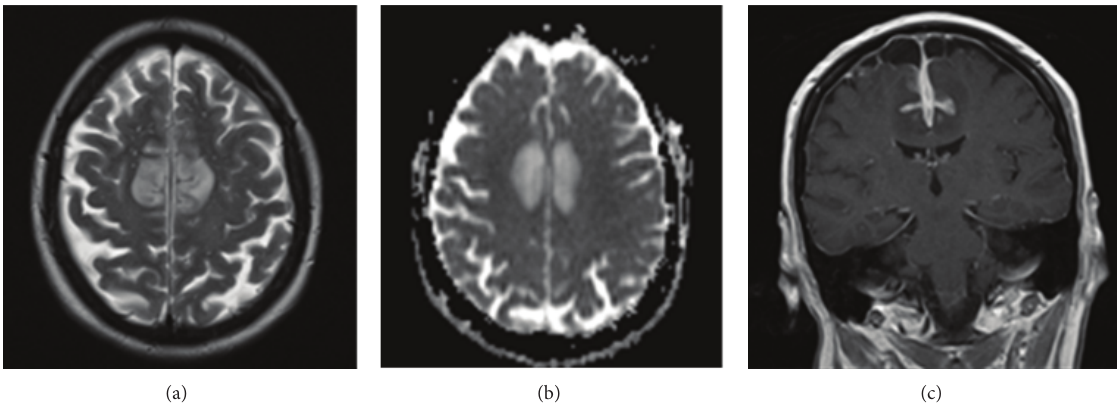
Figure 1: Imaging at presentation (08/2012). (a) Axial T2 image demonstrating moderate parafalcine oedema with local mass effect. (b) Axial apparent diffusion coefficient map confirming free water diffusion, that is, vasogenic oedema. (c) Coronal T1 postcontrast image demonstrating avid parafalcine leptomeningeal and cortical